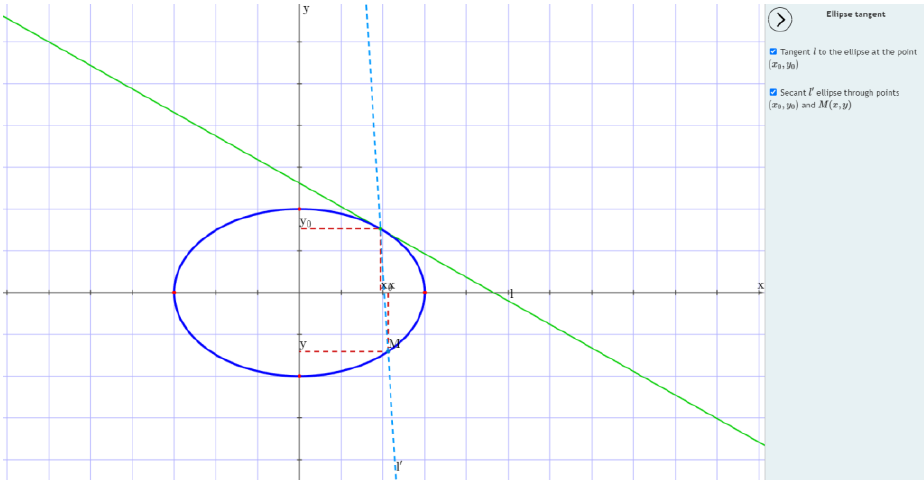
Fig. 2. 2D visualization of a tangent to an